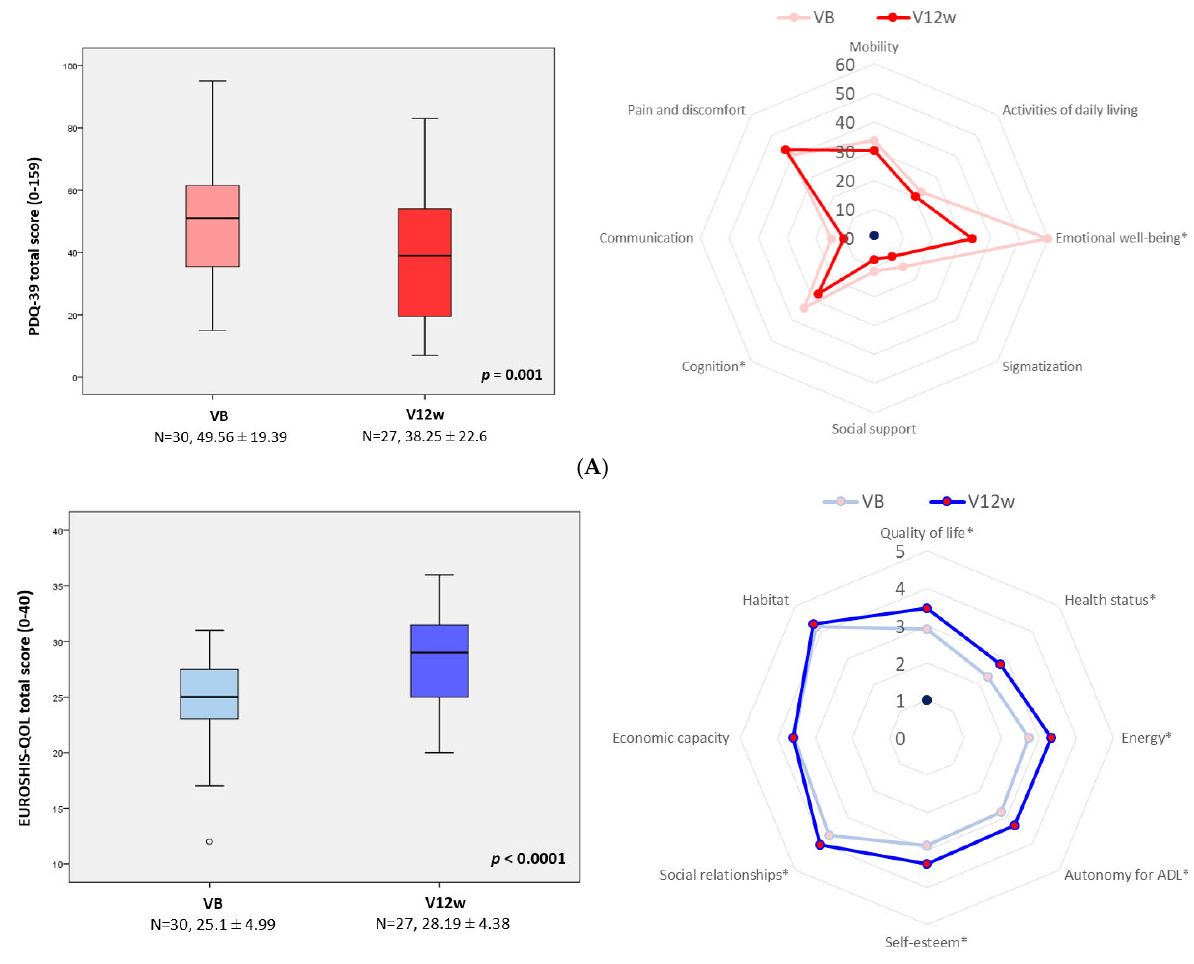
Figure 2. ( A ) PDQ ‐ 39 total score at VB (baseline) and V12w (12 weeks ± 14 days); p = 0.001. Mean score on each domain of the PDQ ‐ 39 at VB and V12 expressed as the Summary Index (range 0–100). The difference between both visits was significant for PDQ ‐ 39D3 (Emotional well ‐ being; p < 0.0001) and PDQ ‐ 39D6 (Cognition; p = 0.033). ( B ) EUROSHIS ‐ QOL8 total score at VB (baseline) and V12w (12 weeks ± 14 days); p < 0.0001. Mean score on each domain (range 0–5) of the EUROHIS ‐ QOL8 at VB and V12w. The difference between both visits was significant ( p < 0.05; Table 2) for all domains except EUROSHIS ‐ QOL8D7 (Economic capacity) and EUROSHIS ‐ QOL8D8 (Habitat). Data are presented as box plots, with the box representing the median and the two middle quartiles (25–75%). p values were computed using the Wilcoxon signed ‐ rank test. Mild outliers (O) are data points that are more extreme than Q1–1.5. PDQ ‐ 39—the 39 ‐ item Parkinson’s disease Questionnaire.